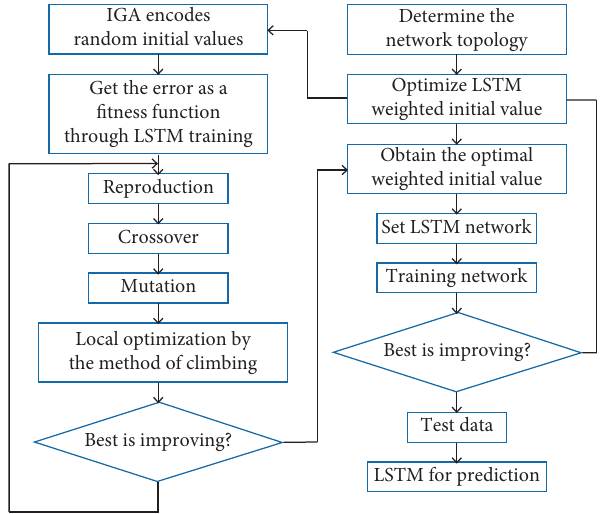
Figure 4: The flow diagram of the proposed